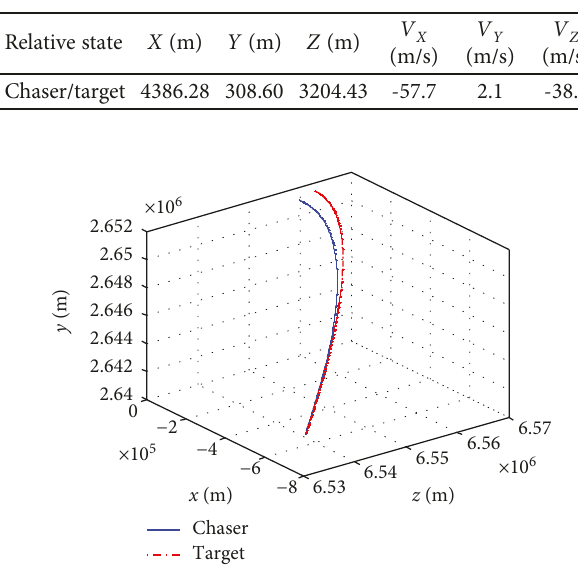
Table 2: Initial relative state between the target and the chaser.